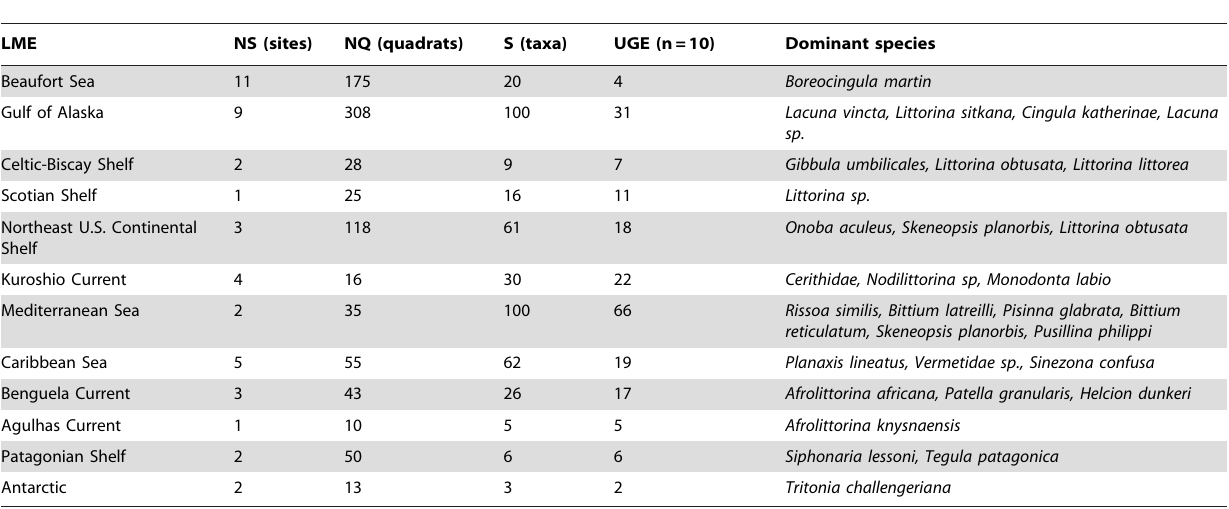
Table 3. Dominant gastropod species or taxa (that amounted to 60% of total densities) for each LME (LMEs ordered by UGE value).